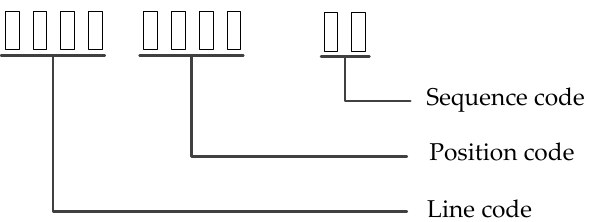
Figure 1. Code structure of the train operation department grid. Figure 2. Code structure of the train operation department grid.